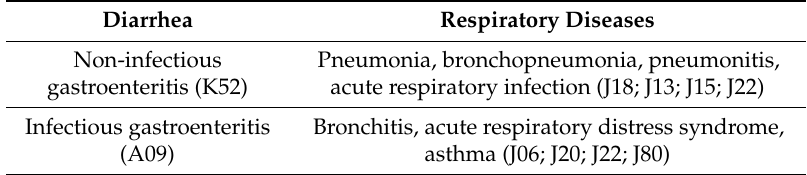
Table 1. Case definitions of diarrhea and respiratory diseases used for data abstraction (ICD-10